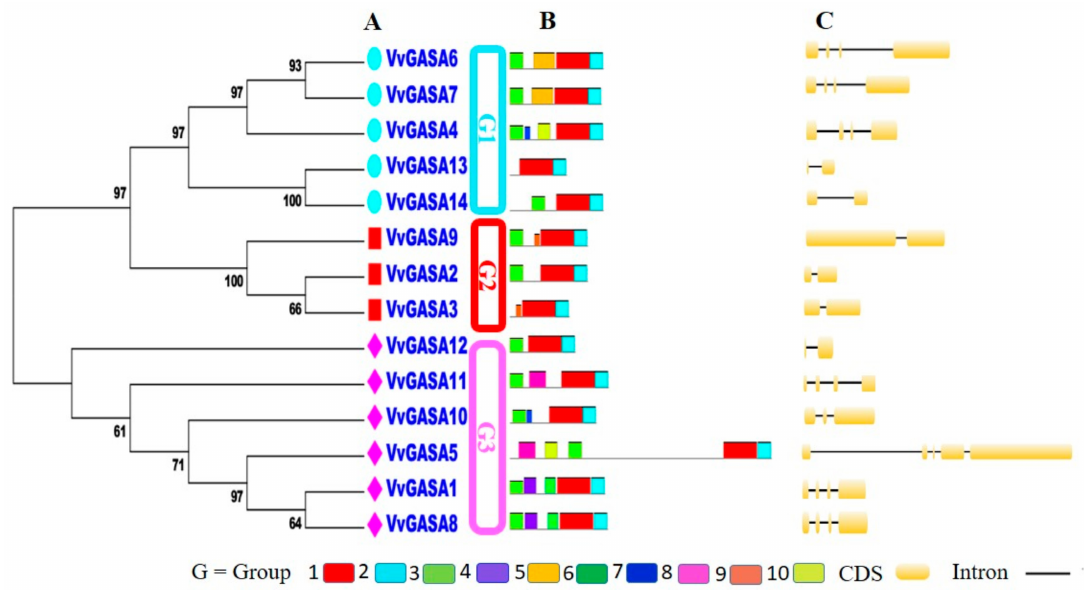
Figure 3. Analysis of grapevine GASA genes. ( A ) Phylogenetic tree of grapevine GASA genes. Di ff erent boxes are colored to indicating di ff erent groups. Numbers near the tree branches indicate bootstrap values. ( B ) Motif analysis. The di ff erent colors of boxes denote di ff erent motif numbers. The length of box indicates motif length. ( C ) Exon-intron distribution. CDS denotes